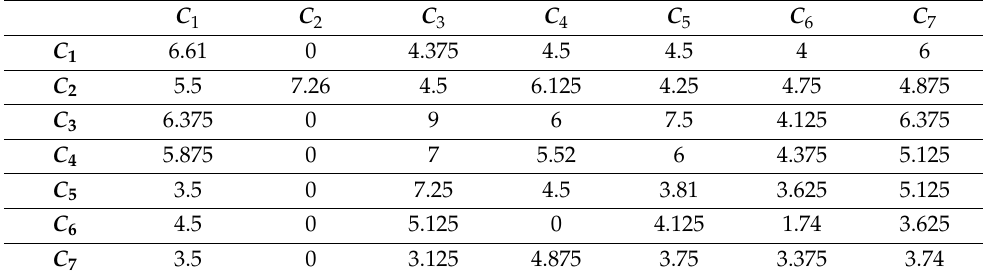
Table 8. WINGS directed matrix.